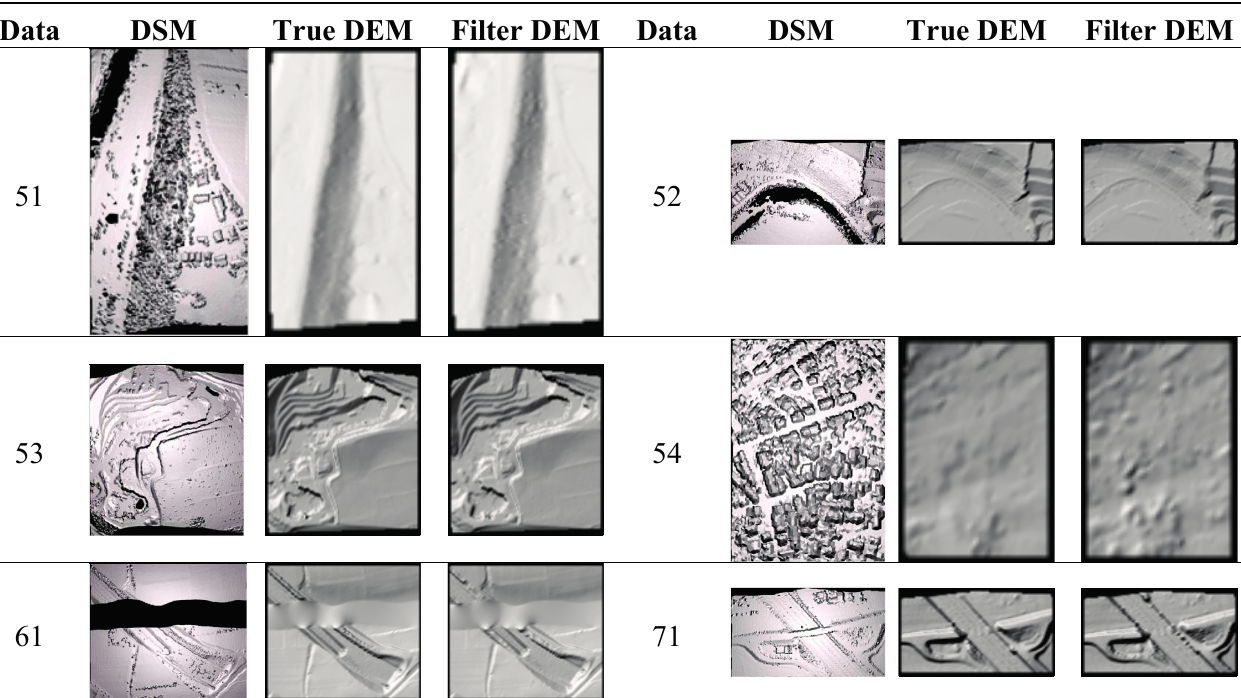
Table 4. DSMs generated from the raw point clouds, DEMs generated from the true ground points, and DEMs generated from the ground points derived by the proposed filter for rural sample